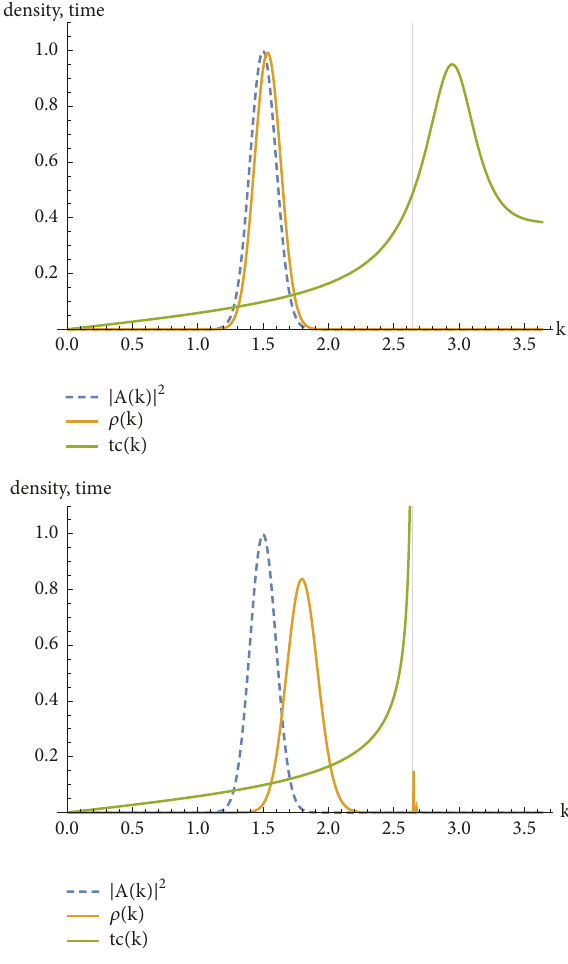
Figure 1: Stationary transmission clock time 𝑡 𝑇 𝑐 (𝑘) (green) and the distributions 𝜌(𝑘) (orange and arbitrary scale) and |𝐴(𝑘)| 2 (blue, dashed, and arbitrary scale) for the transmitted and incident wave packets, respectively. Rydberg atomic units ℏ = 2𝜇 = 1 are used in all plots; the tunneling energies correspond to 0 < 𝑘 < √7 , corresponding to a barrier height 𝑉 0 = 7 (the maximum tunneling wavenumber √7 isshownbyaverticalgreylineintheplots).Inboth plots the incident wave packet parameters are 𝑘 0 = 1.5,𝜎 = 5, 𝑥 0 = −8𝜎 . Top: barrier width 2𝐿 = 2 . Bottom: barrier width 2𝐿 = 16